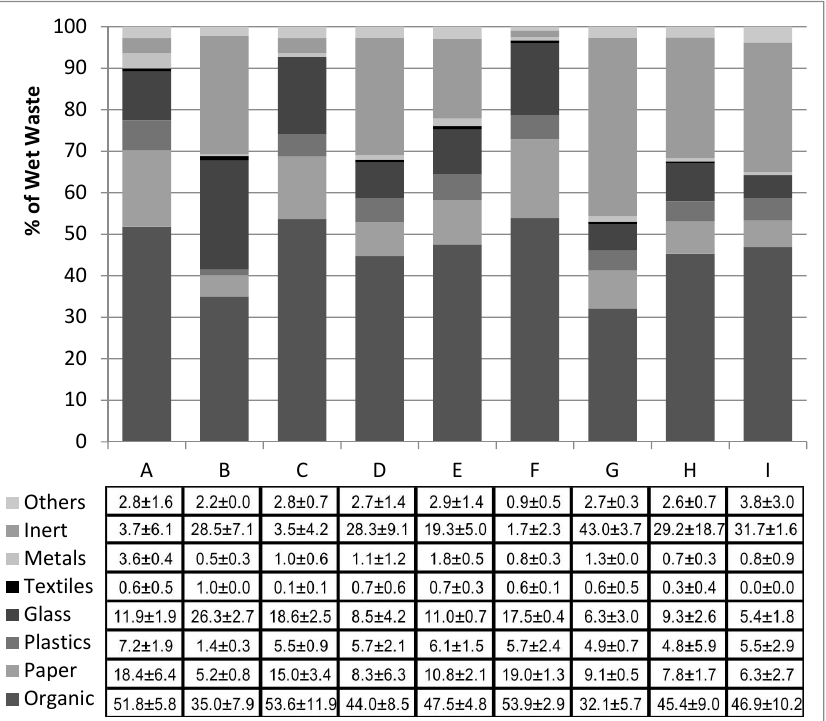
Figure 1. The average composition of the organic fraction of municipal solid waste (OFMSW) samples directed for biological treatment in the plants that used particular waste treatment technologies.